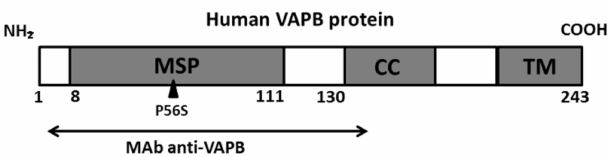
Figure 1. Schematic representation of the vesicle-associated membrane-protein-associated protein B (VAPB). The arrow indicates the recognition site for an anti-VAPB monoclonal antibody (2-130 aa) used for flow cytometry assays (FCAs). This site includes the N-terminal domain (8-111 aa) of the protein, called MSP that can be a ff ected by P56S